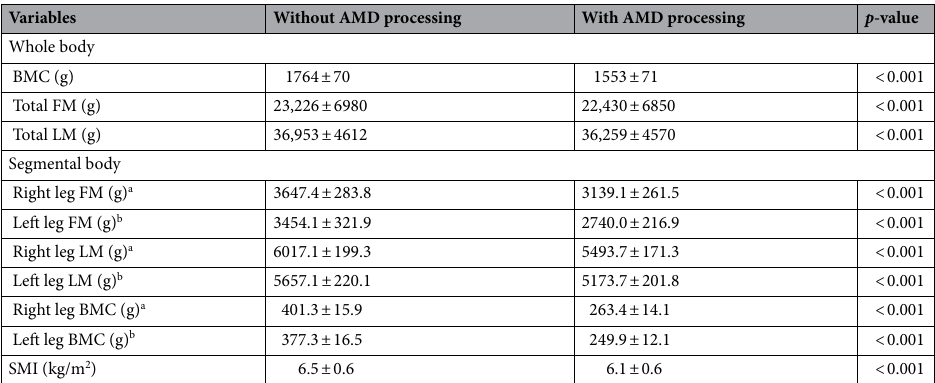
Table 2. Body compositions of the study participants measured using whole-body dual X-ray absorptiometry with and without automatic metal detection processing ( n = 24). Values are presented as means ± standard deviations. AMD automatic metal detection, BMC bone mineral content, FM fat mass, LM lean mass, SMI skeletal muscle mass index. Out of the 24 participants who underwent total knee replacement (TKR) surgery, six underwent right-knee TKR surgery, four underwent left-knee TKR surgery, and 14 underwent TKR surgery in both knees. a The number of participants who underwent right-knee TKR surgery was 20. b The number